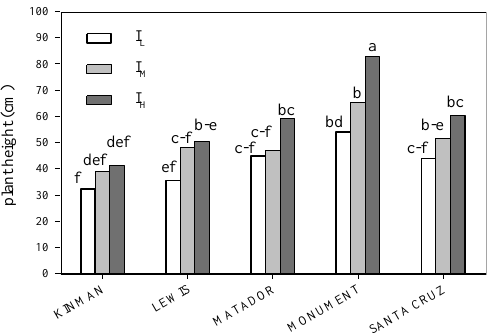
Figure 6. Two-year plant height (cm) across three levels of irrigation among five guar cultivars. Bars with different letters differ for p < 0.05.